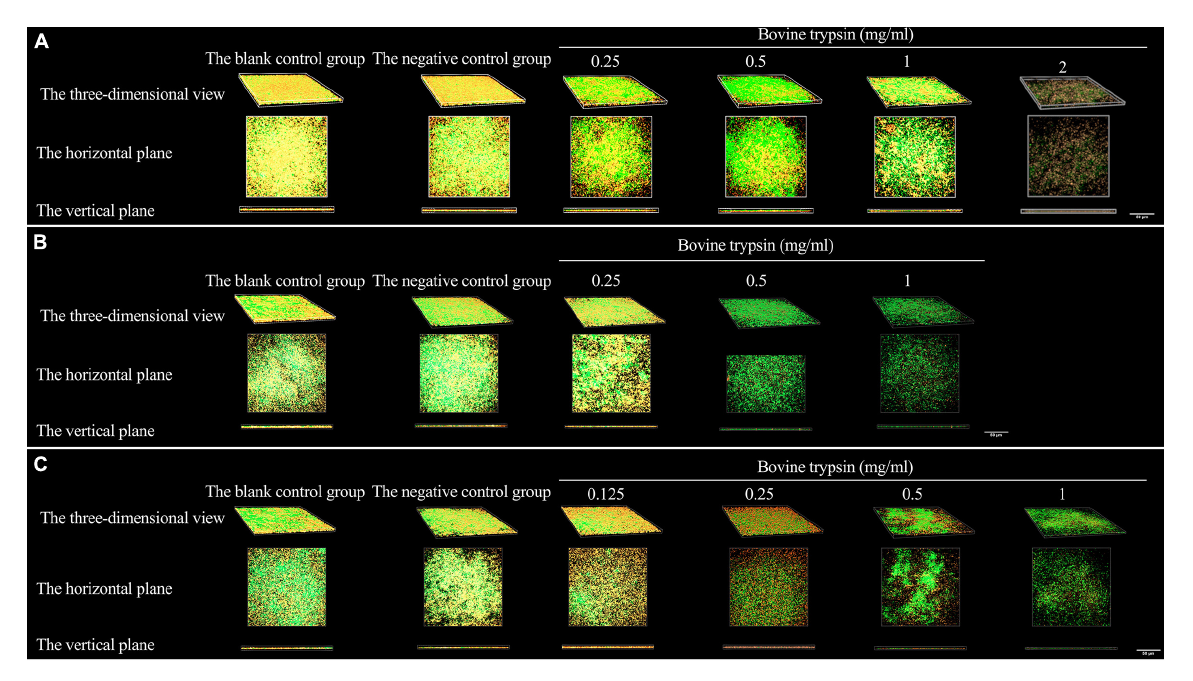
FIGURE3 The three-dimensional morphology observation of biofilm EPS after 30 s, 1 min, and 3 min of bovine trypsin treatment by CLSM. (A) The morphology of EPS after 30 s of action by bovine trypsin. (B) The morphology of EPS after 1 min of action by bovine trypsin. (C) The morphology of EPS after 3 min of action by bovine